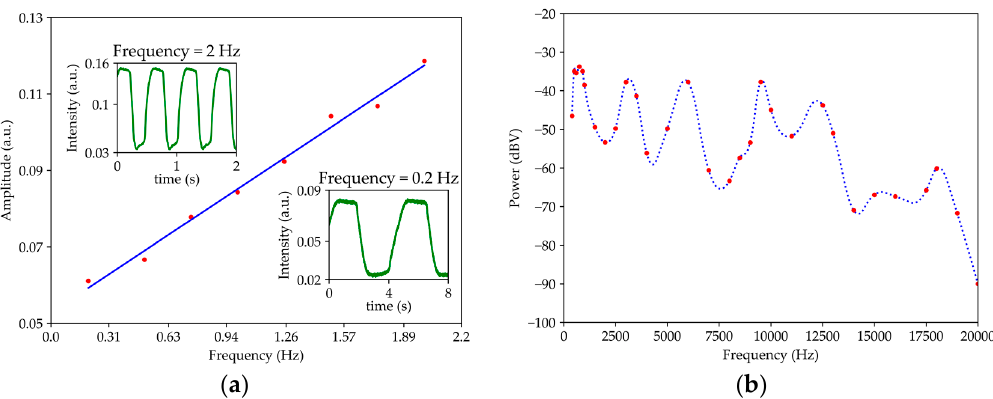
Figure 11. Transfer function in relation to an oscillating surface for a wavelength of 1570 nm and with the sensor perpendicular to the oscillating plate: ( a ) 0.2 Hz to 2 Hz and ( b ) 400 Hz to 20 kHz.